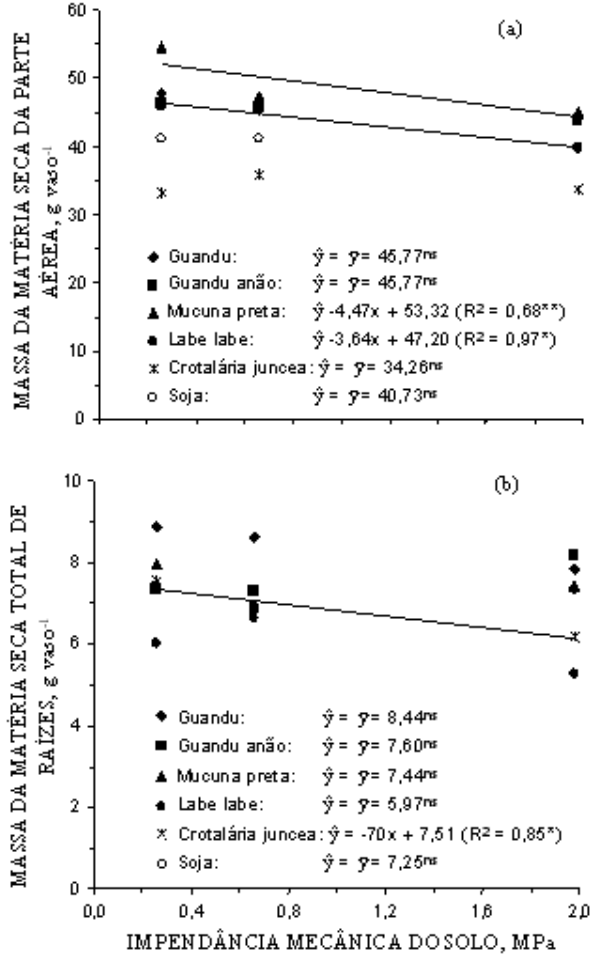
Figura 2. Massa da matéria seca da parte aérea (a) e massa da matéria seca total de raízes (b), das plantas de cobertura e da soja resultante da impedância mecânica do solo. * e ** significati- vos a 5 e 1 %, respectivamente. ns: não-signifi-